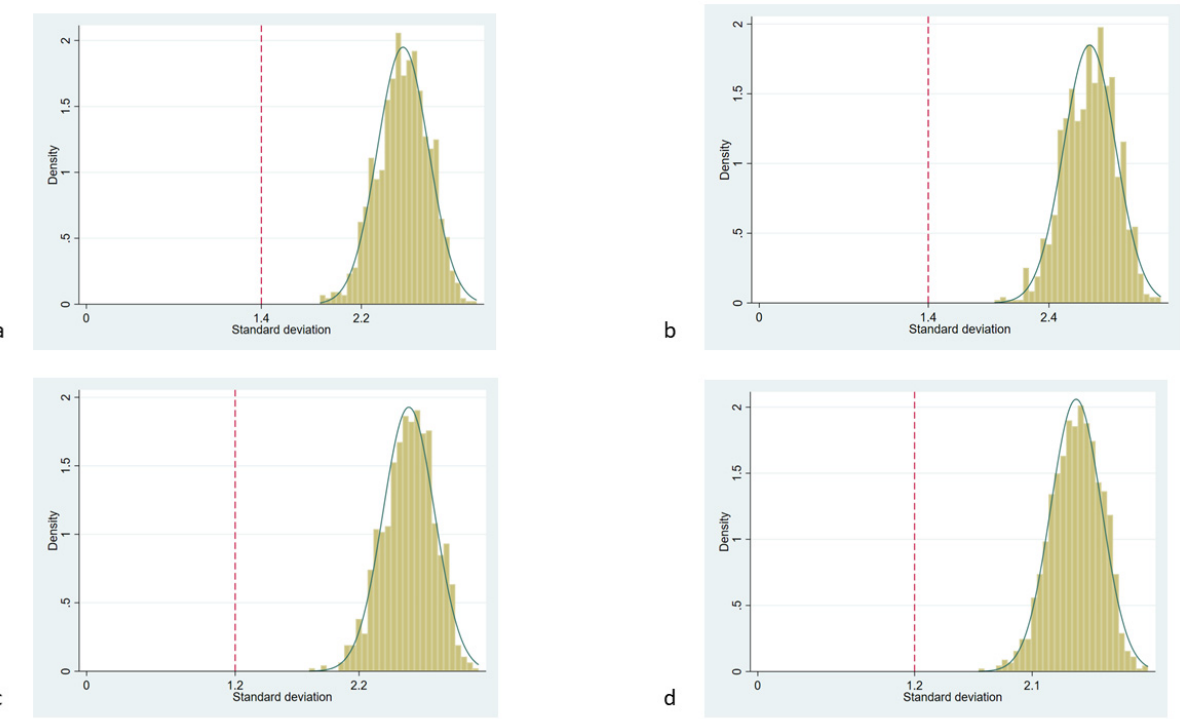
Figure 1. Results of the Preiss–Fisher procedure. The Preiss–Fisher diagrams show the SD of the differences of the Bland–Altman agreement analysis (red dotted line) and the distribution of the SDs of the differences from 1000 random mispairings of the rater/reference data with the 5th percentile value. ( a ) Rater 1/reference, ( b ) rater 2/reference, ( c ) rater 3/reference, and ( d ) rater 4/reference.